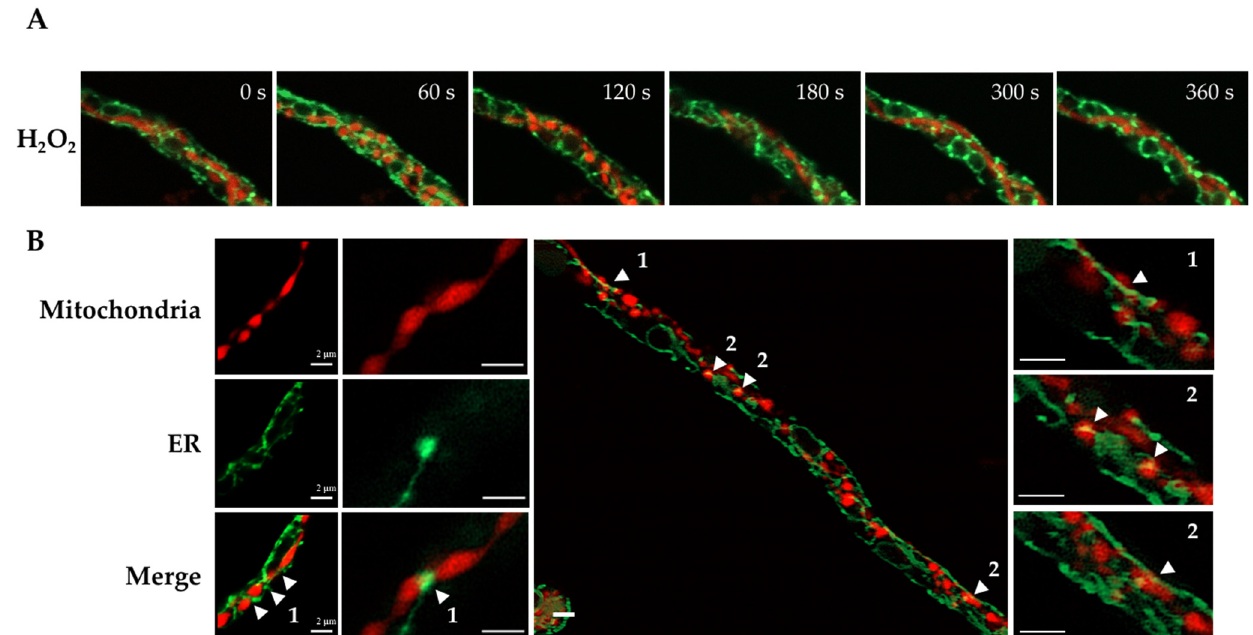
Figure 5. H 2 O 2 -induced mitochondrial constriction sites are in close contact with the endoplasmic reticulum. Mycelia from Δ dnmA (CVG32) mutant strain was grown for 18 h and treated with 5 mM H 2 O 2 for 20 min. H 2 O 2 was removed, and after a 10-min additional incubation, hyphae were observed at the indicated times using confocal microscopy. ( A ) Changes in the mitochondria–ER morphology after H 2 O 2 treatment. ( B ) Magnification of the mitochondria–ER contacts during H 2 O 2 -induced mitochondrial constrictions. The samples were treated as in ( A ), fixed, and observed using Airyscan microscopy. Labels 1 and 2 point to examples of different types of mitochondrial–ER interactions. The red and green signals correspond to mitochondria labelled with mCherry and ER labelled with GFP, respectively. The arrowheads point to mitochondria–ER contacts. Scale bar = 2 µm.